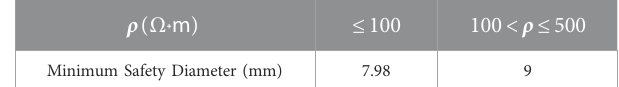
TABLE 1 Minimum safety diameter